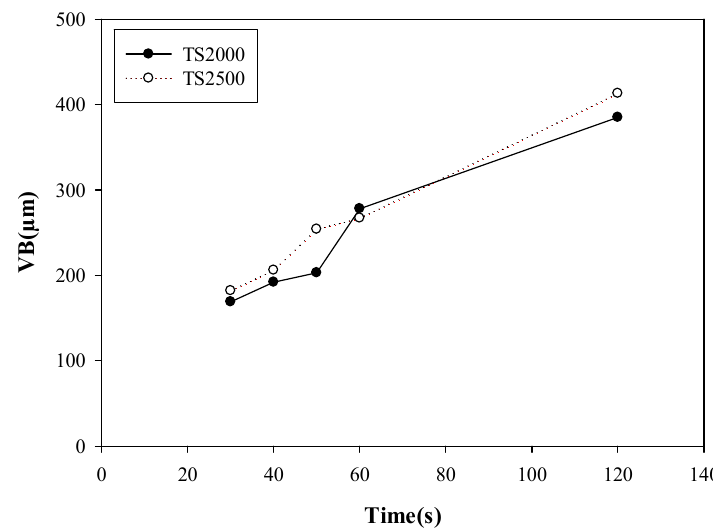
Figure 14. Flank wear (VB) under wet mode in both inserts.